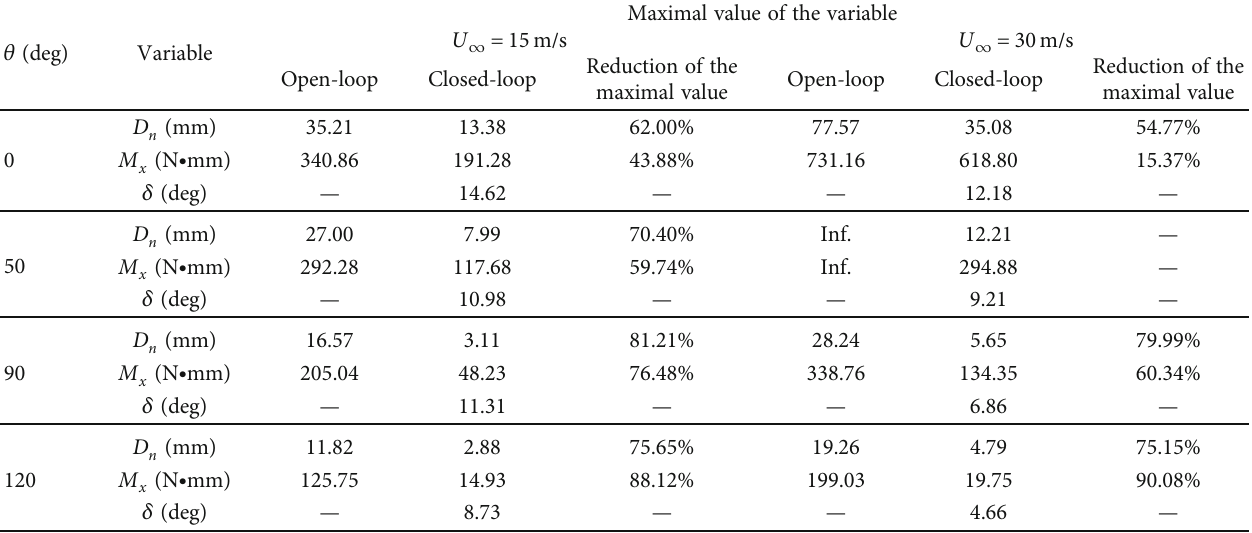
Figure 19: Dynamic responses of the open and closed-loop systems to the 1-cos discrete gust ( θ = 90 deg, U Table 1: Maximum values of the wing-tip displacement ( D gust responses.